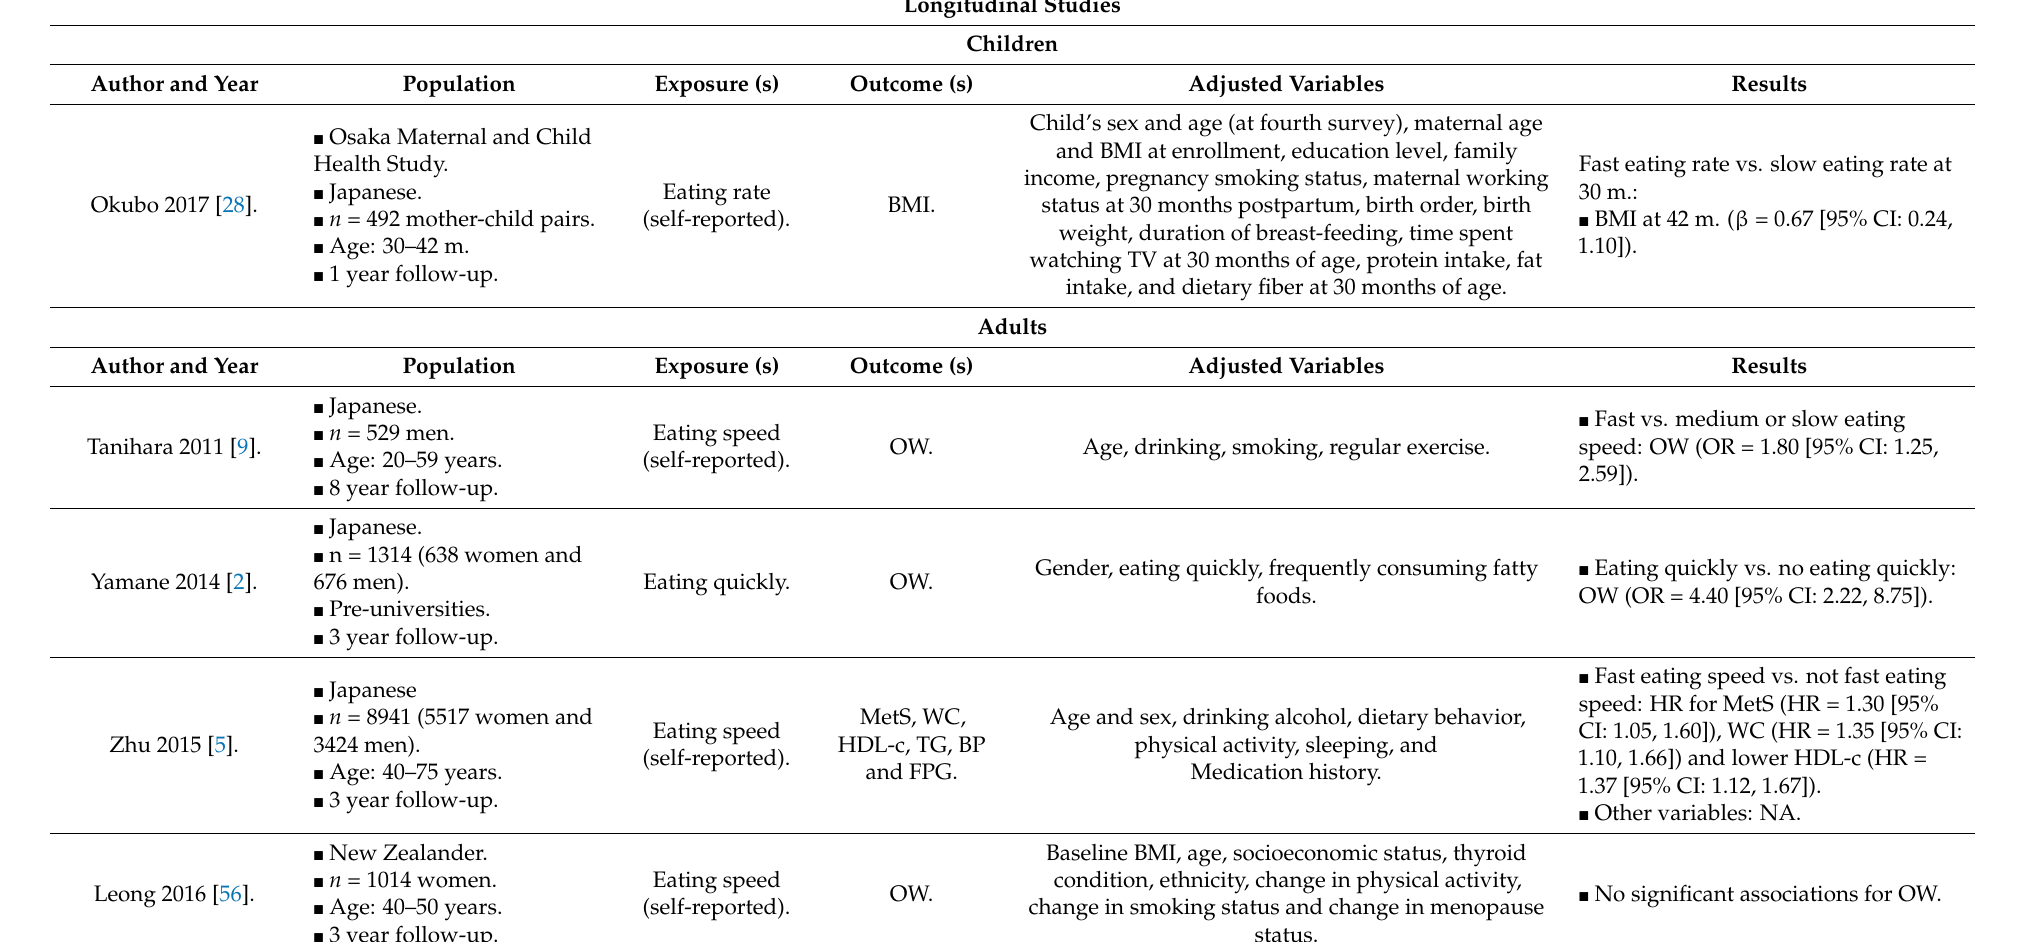
Table 3. Characteristics and main findings of longitudinal studies that explored eating speed/rate. Longitudinal Studies